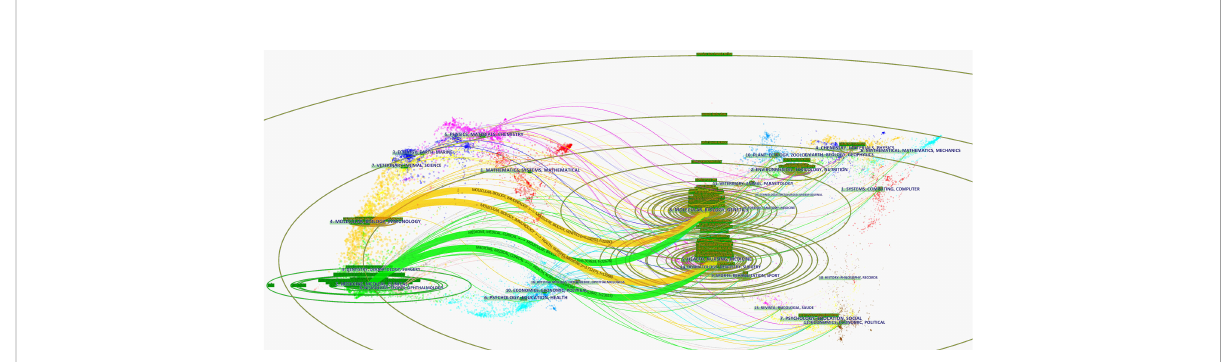
FIGURE 11 The dual-map overlay of journals stood for the topic distribution of academic journals involving PCOS research (generated by Citespace). The colored connecting lines represent citation relationship. The cited journals were on the right, and the citing journals were on the